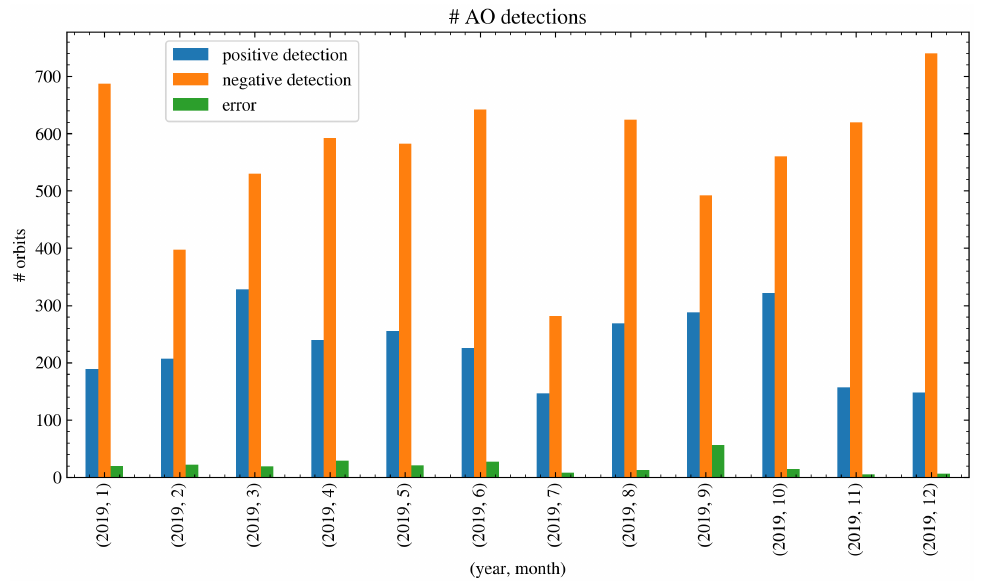
Figure 17. AO detection results in the southern hemisphere for CSES-01 orbits available in 2019. Blue and orange histograms denote positive and negative detection, respectively, while green histograms denote available orbits that could not be successfully